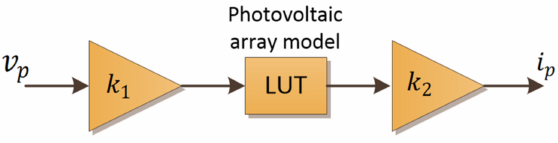
Figure 10. Photovoltaic array emulator